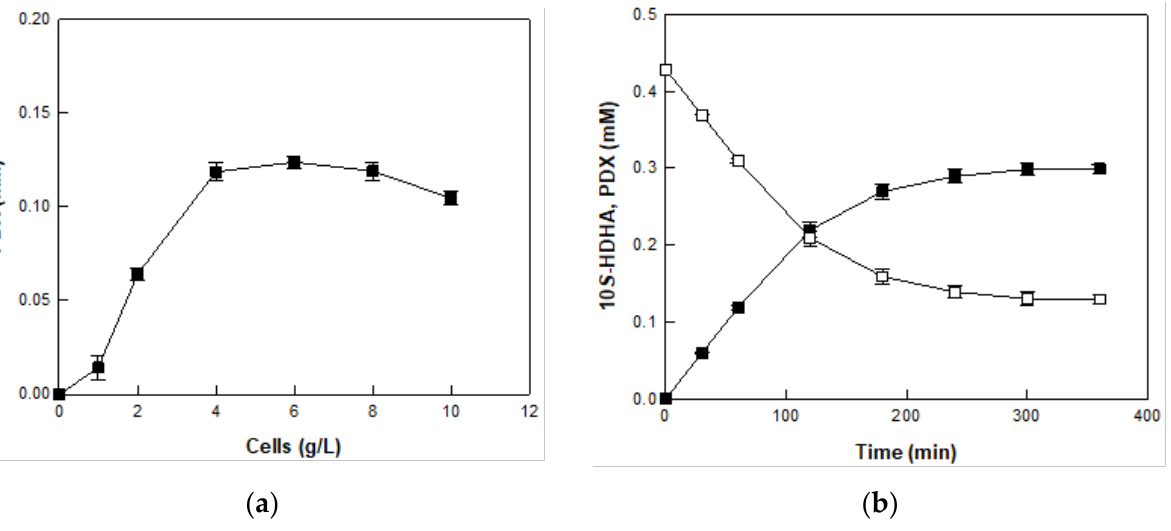
Figure 5. ( a ) Effects of cell concentration and ( b ) time-course reactions to produce PDX (filled square) from 10S-HDHA (empty square) in MO 8SLOX-treated DFOH. The reactions were performed with E. coli cells expressing BT 15SLOX, substrate (10S-HDHA), and cysteine in 50 mM HEPES buffer (pH 7.5) at 30 °C for 1 h. Data represent the means of three experiments and error bars represent standard deviations.